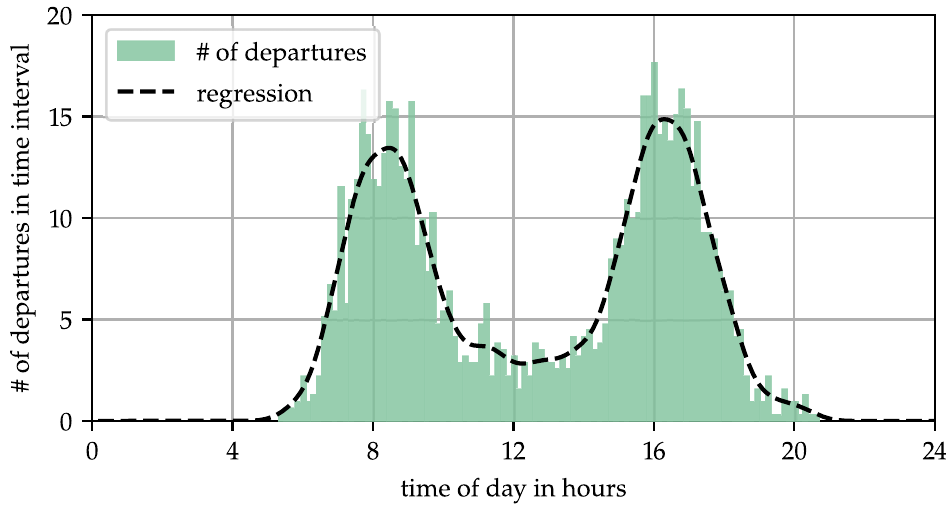
Figure 1. Temporal distribution of departing trips over the course of 24